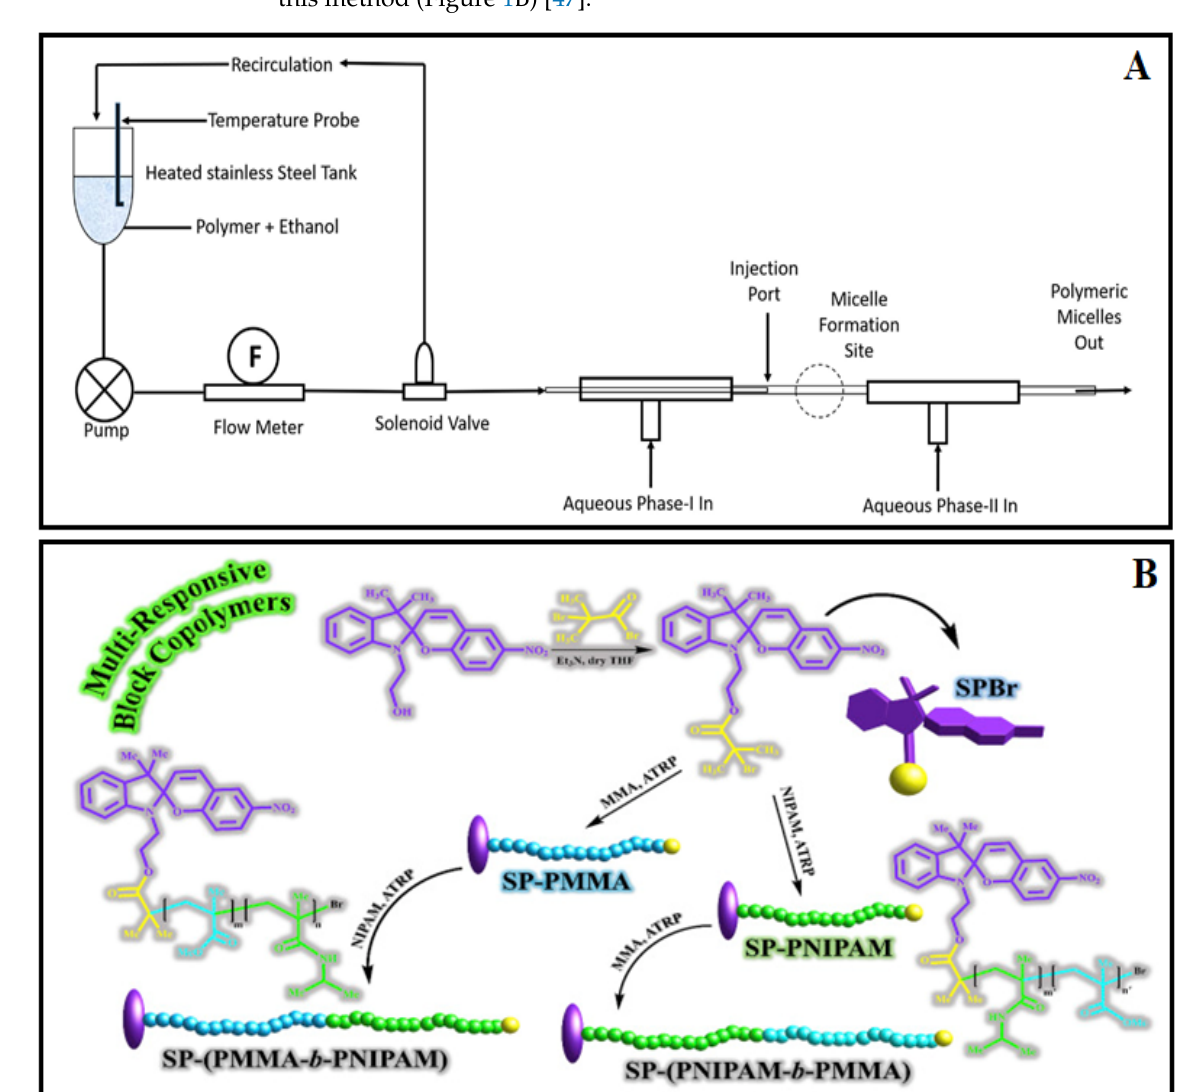
Figure 1. ( A ) Schematic representation of continuous processing method for micelle formation. Reprinted with permission from [14] © Elsevier 2020. ( B ) Schematic representation of the design of multi-responsive block copolymers having spirogyra end groups by atom transfer polymerization method. Reprinted with permission from [47] © Elsevier